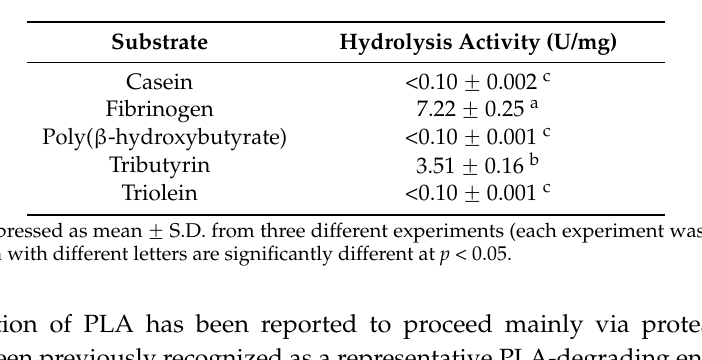
Figure 4. Effects of pH and temperature on the activity and stability of the PLA depolymerase from P. tamsuii TKU015. ( a ) Optimum pH; ( b ) pH stability; ( c ) optimum temperature; ( d ) thermal stability.